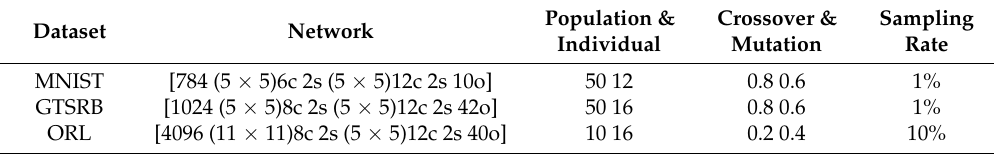
Table 2. Architectures of two structures and parameters of MPGA